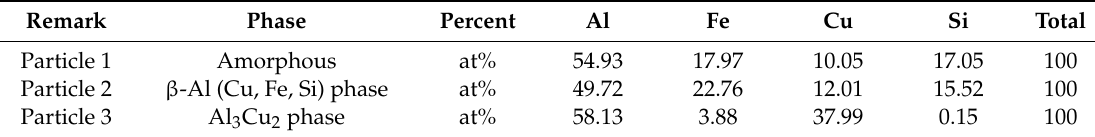
Table 2. EDS results of di ff erent powder